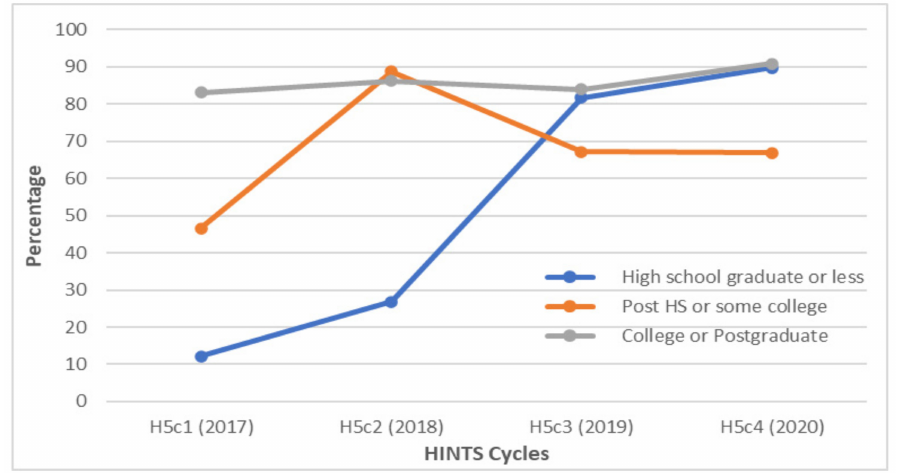
Figure 3. Awareness of HPV among gay and bisexual males according to education status between 2017 and 2020. Over 80% of GBM with college or postgraduate levels of education were aware of HPV each year. The largest increase in awareness occurred between 2018 and 2019 among GBM with a high school level of education or less; HS = high